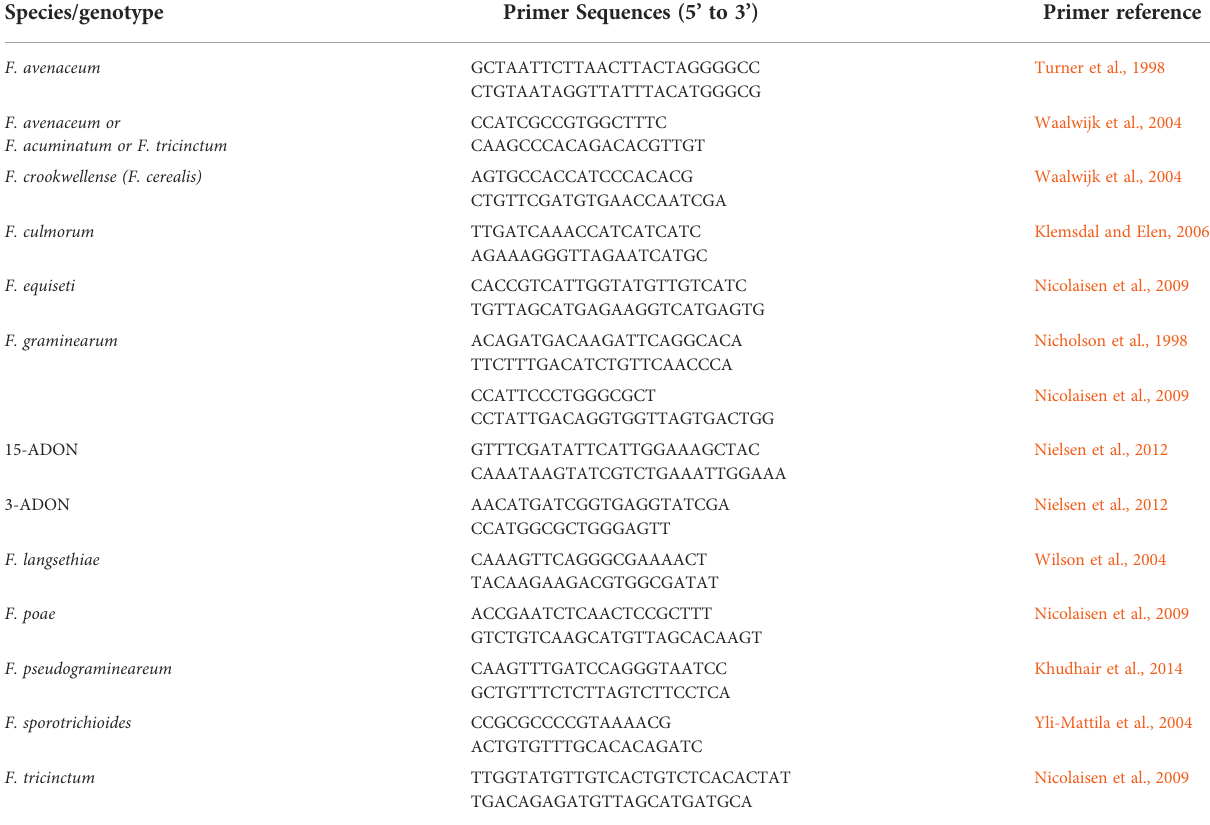
TABLE 1 Primer sequences of each Fusarium species and ADON genotype used in this